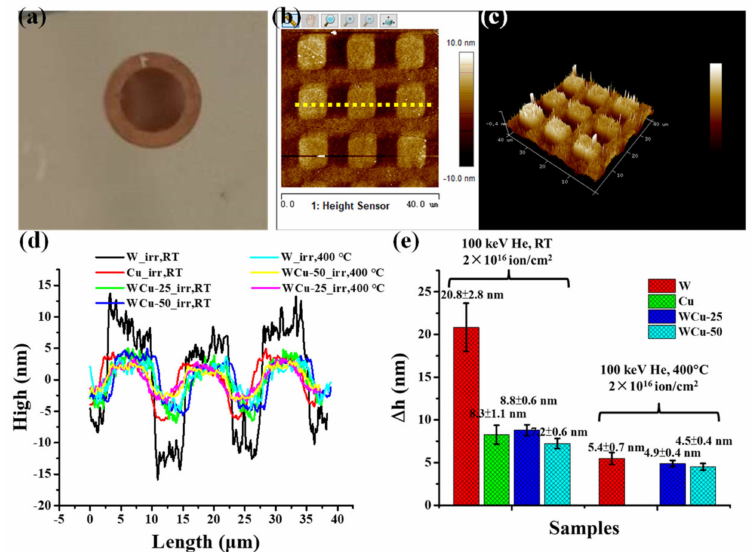
Figure 2. ( a ) The copper mask with 2000 mesh; ( b ) the typical AFM topographical 2D image; ( c ) 3D image of W/Cu-50 after He irradiation at RT with 2 × 10 16 ions/cm 2 ; ( d ) relative height along the yellow dot line in ( b ); ( e ) the statistics of the swelling height of the